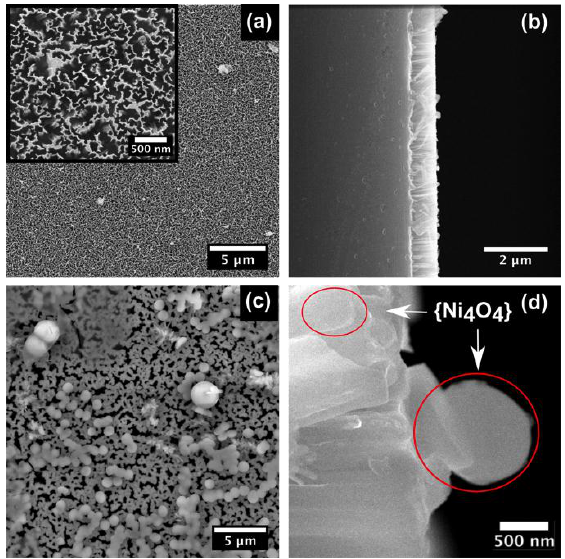
Figure 2. SEM images ( a , b ) top and cross section view of bare SiNWs. Inset in Figure 1 a represents islands of SiNWs; ( c , d ) top and cross section view of SiNWs coated with {Ni 4 O 4 } clusters.